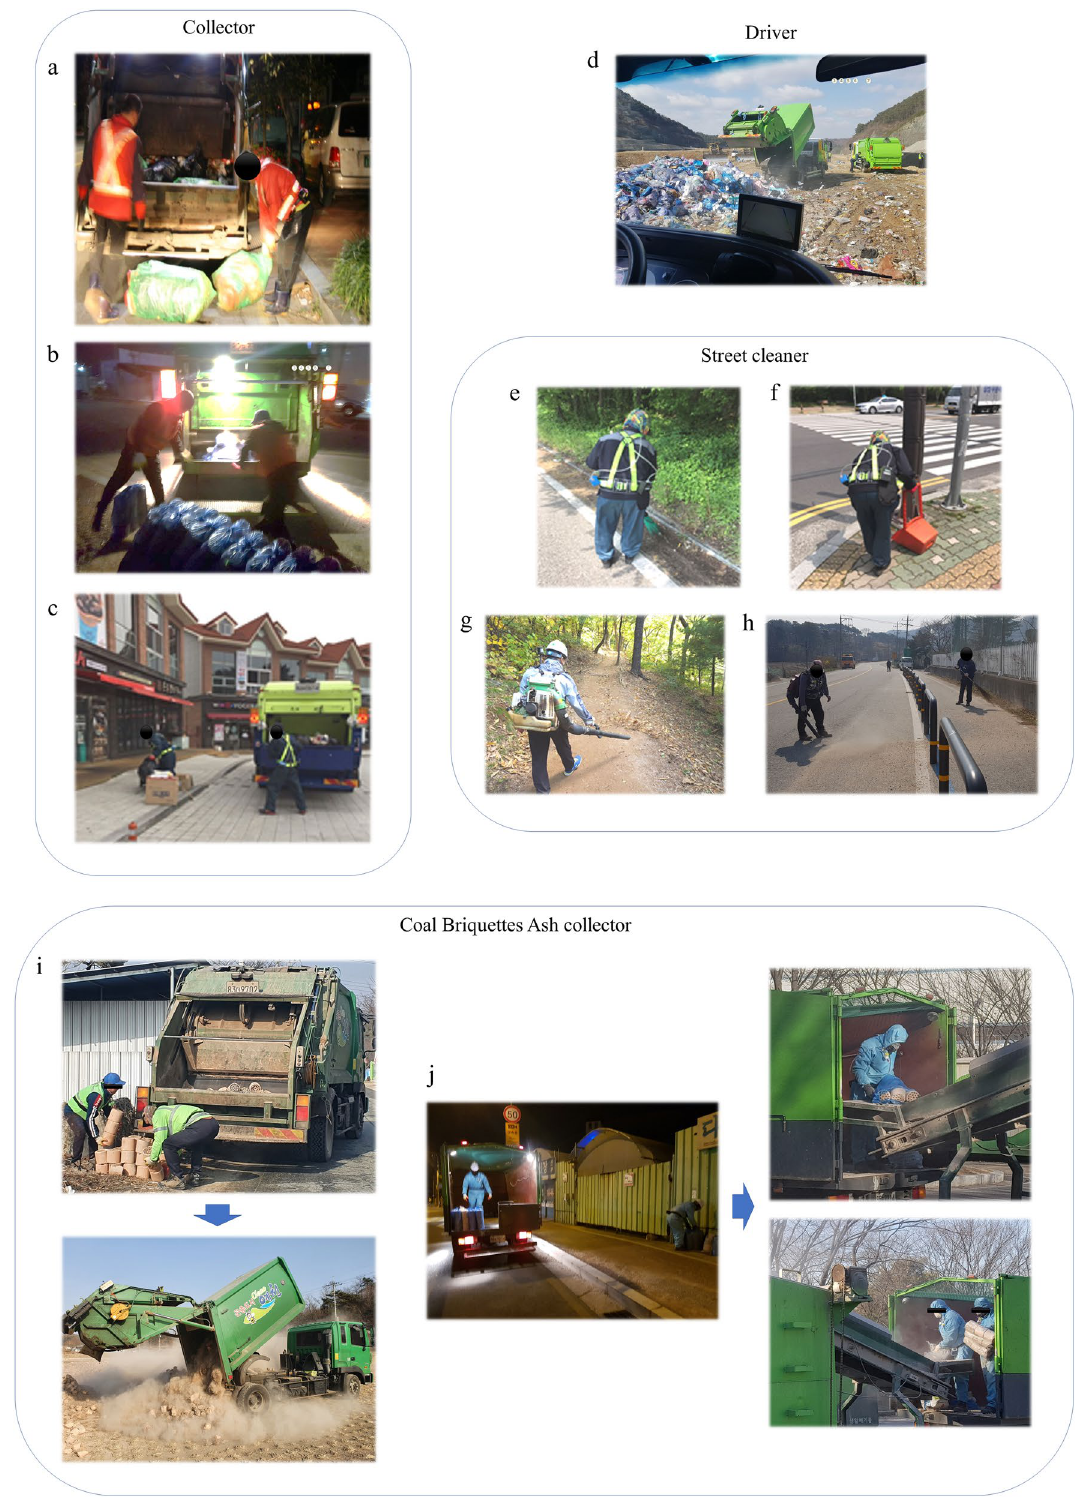
Figure 1. Tasks of the sanitation workers in this study. ( a ) loading general garbage in a truck, b: Loading CBA in a truck, ( c ) loading recyclable garbage in a truck, ( d ) driver of garbage truck, ( e ) sweeping the road, ( f ) Picking up trash, g: air blowing fallen leaves, ( b ) air blowing road sand, ( i ) the CBA is manually loaded onto the truck, and the truck automatically unloaded the CBA. ( j ) Manually loading and unloading briquettes into a